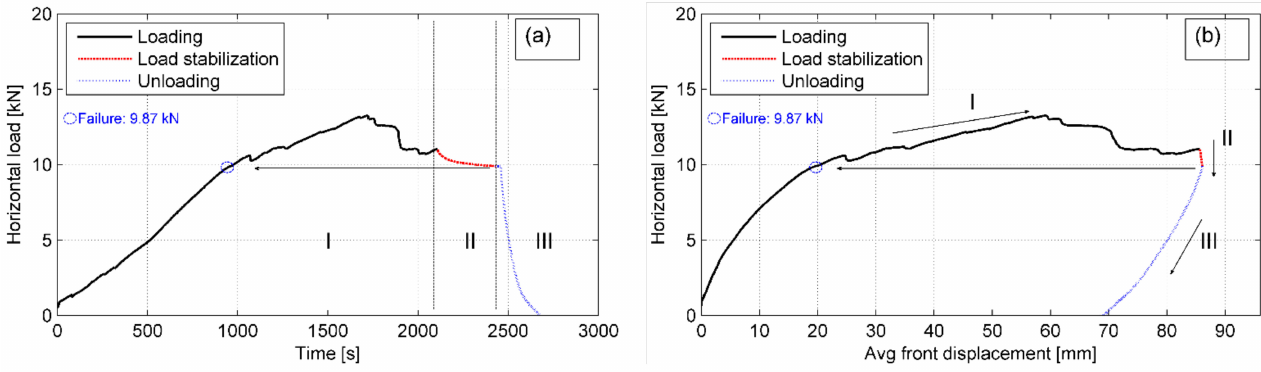
Figure 17. Typical curves for P-4 specimen in stage I: ( a ) load–time curve; ( b ) load–displacement curve for average front